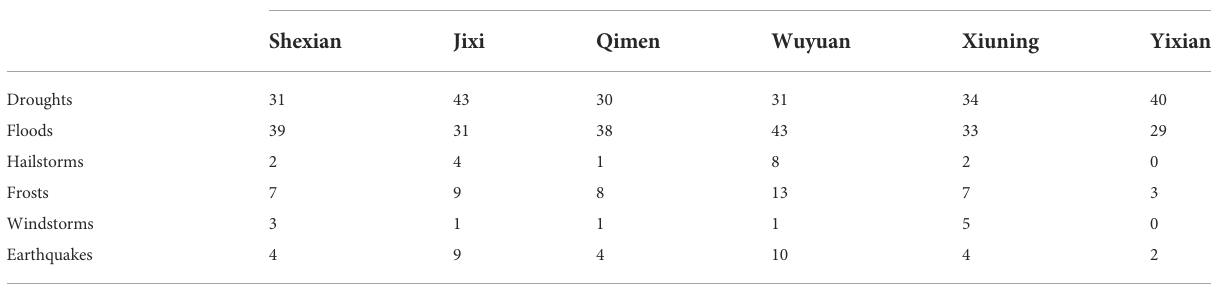
TABLE 2 Frequencies of the natural disasters in different counties in the Huizhou region during the Ming and Qing dynasties. Natural disaster